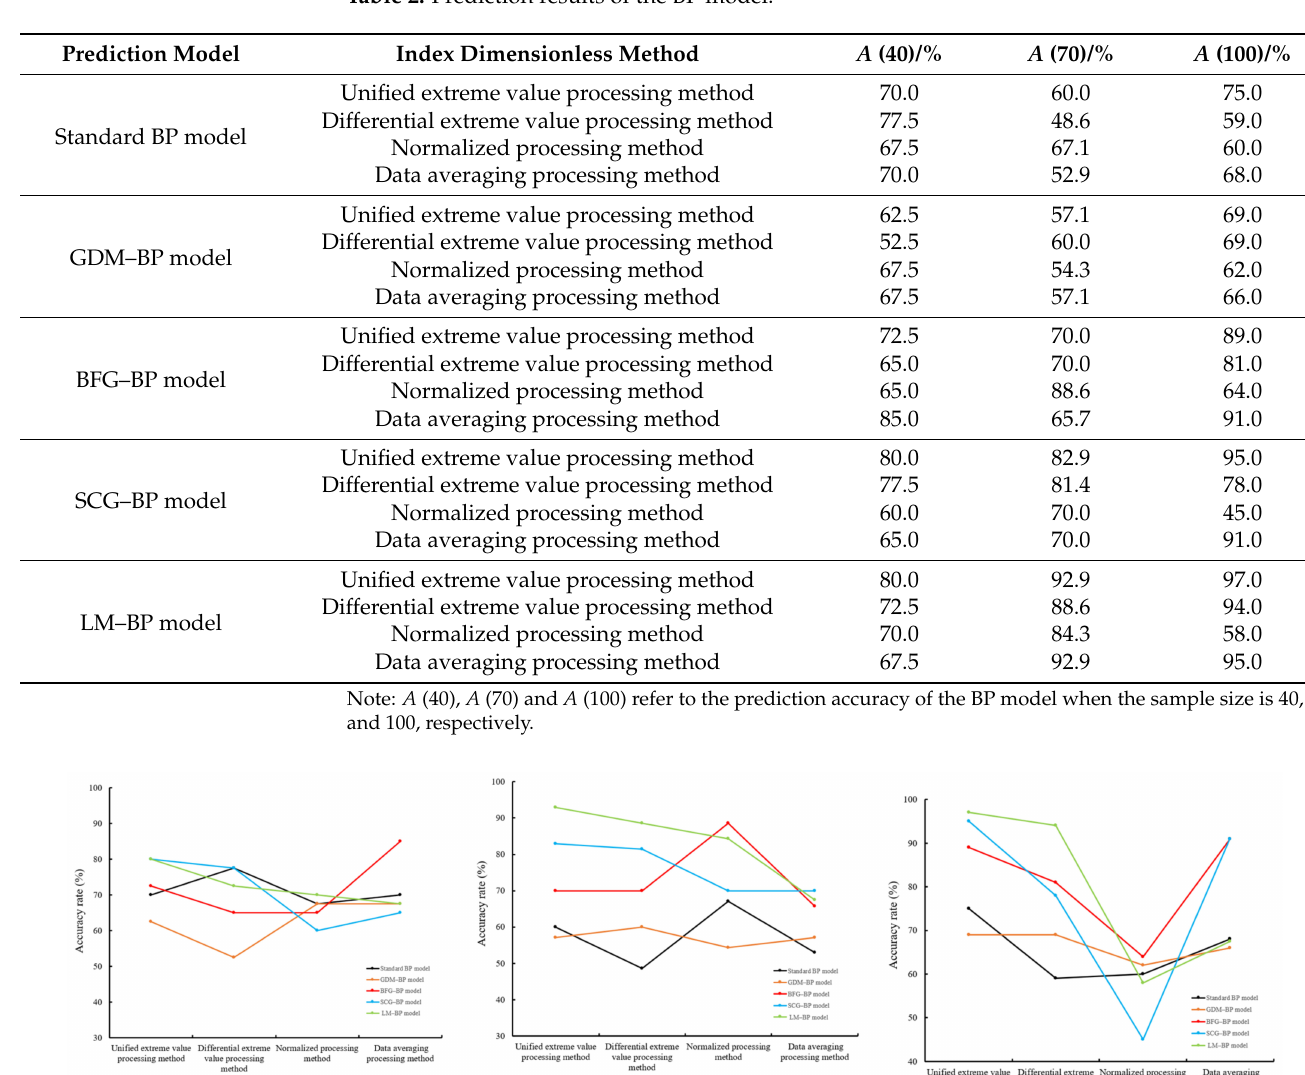
Table 2. Prediction results of the BP model.